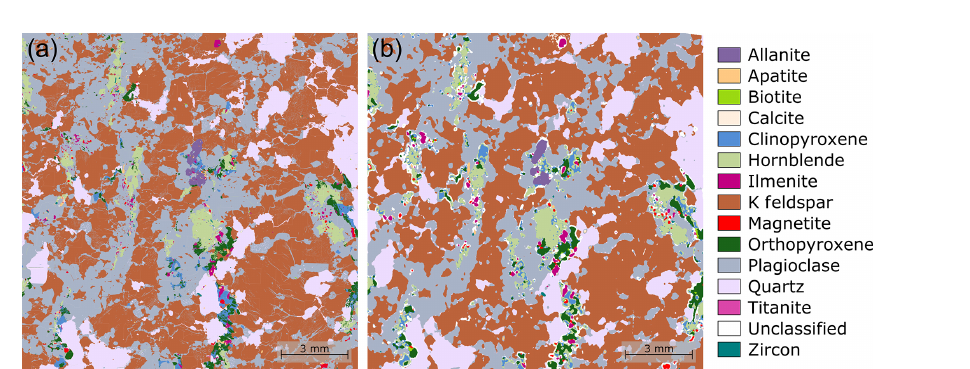
Figure 4. Detailed view of a section in the upper right corner of sample 342: mineral distribution map from MLA (a) and ENVI (b) .